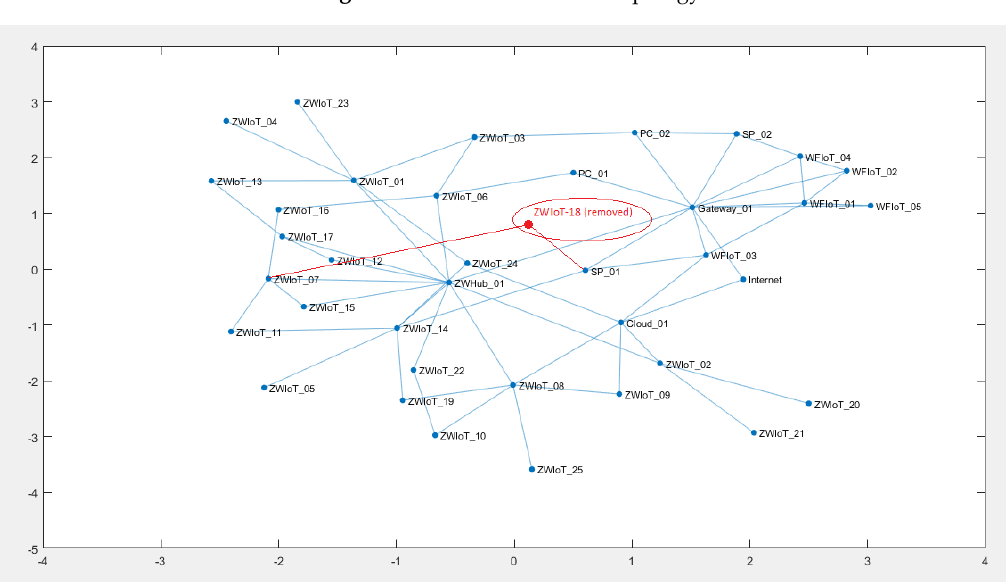
Figure 2. Generated network topology.